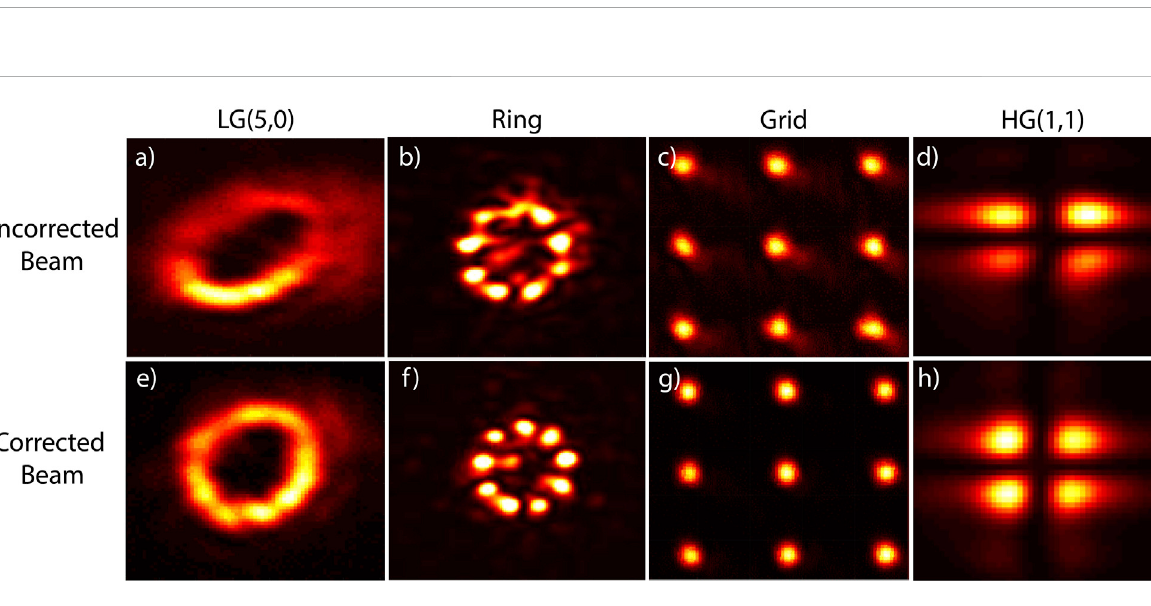
FIGURE 5 Comparison of uncorrected (A – D) and corrected (E – H) beams commonly used in holographic optical tweezers systems. (A , E) Laguerre- Gaussian (LG) beams with a topological charge of L (cid:2) 5. (B , F) 10 optical traps equally spaced along a ring of radius 10 μ m demonstrating strong interference between neighbouring foci for the uncorrected beam. (C , G) 3 × 3 grid generated using a weighted Gerchberg-Saxton algorithm (Di Leonardo et al., 2007). We observe greater trap intensity and uniformity along with a signi fi cant reduction in unwanted stray light surrounding each foci. (D , H) Comparison of Hermite-Gaussian (HG) beams with modes m , n = 1, 1. All images are obtained using a USB CCD camera situated in the conjugate plane of the SLM with identical laser powers and camera exposure settings for uncorrected and corrected image